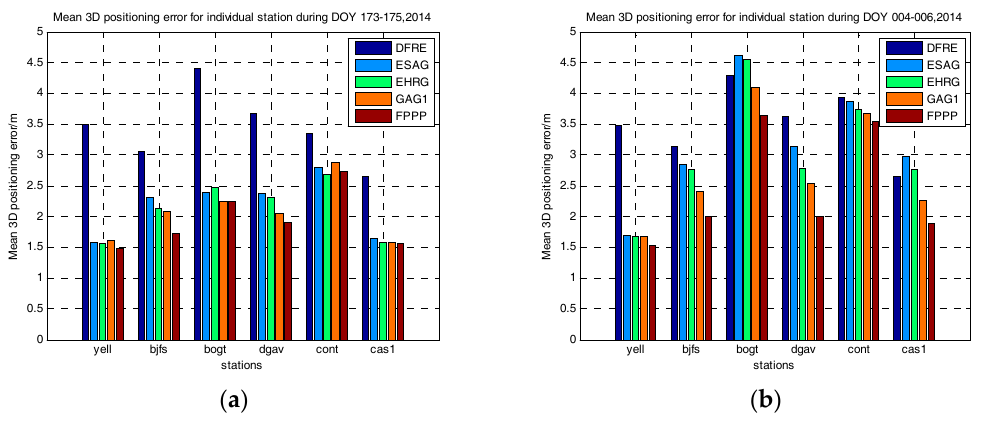
Figure 3. Mean 3D positioning error of individual station for Case 1 ( a ) and Case 2 ( b ).